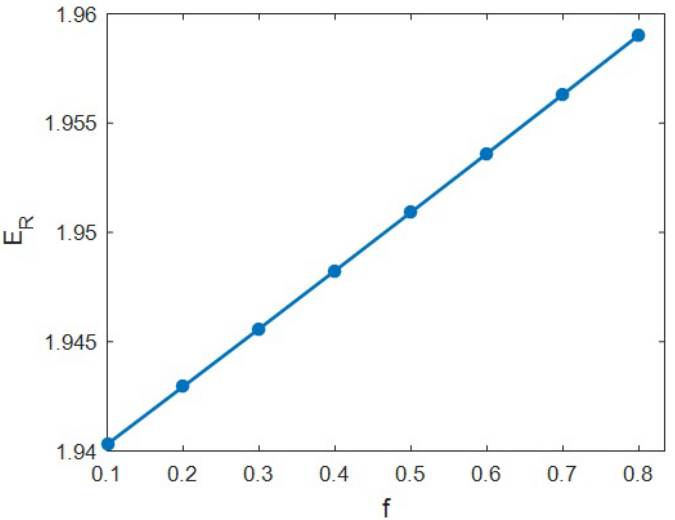
Figure 9. A plot between “ E R ” and the portion of network using the advanced model.